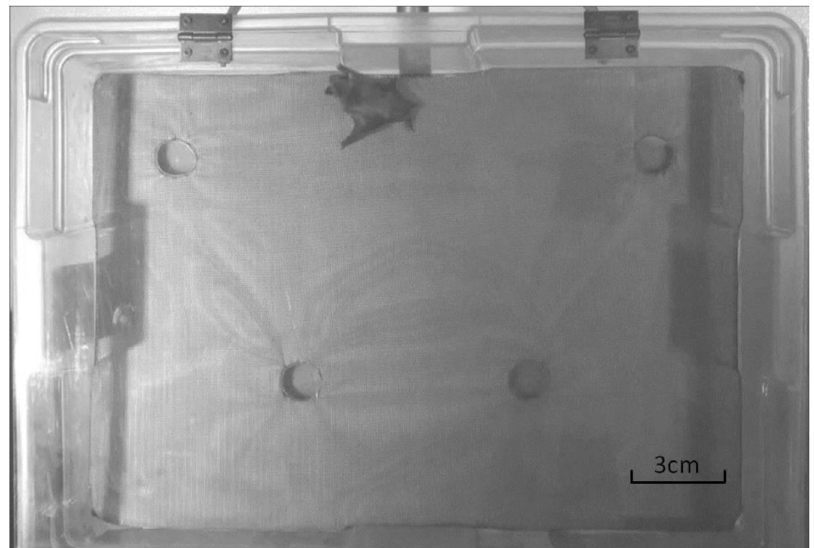
Figure 1. Screen capture of our modified hole-board test from a video recording of a behaviour trial.